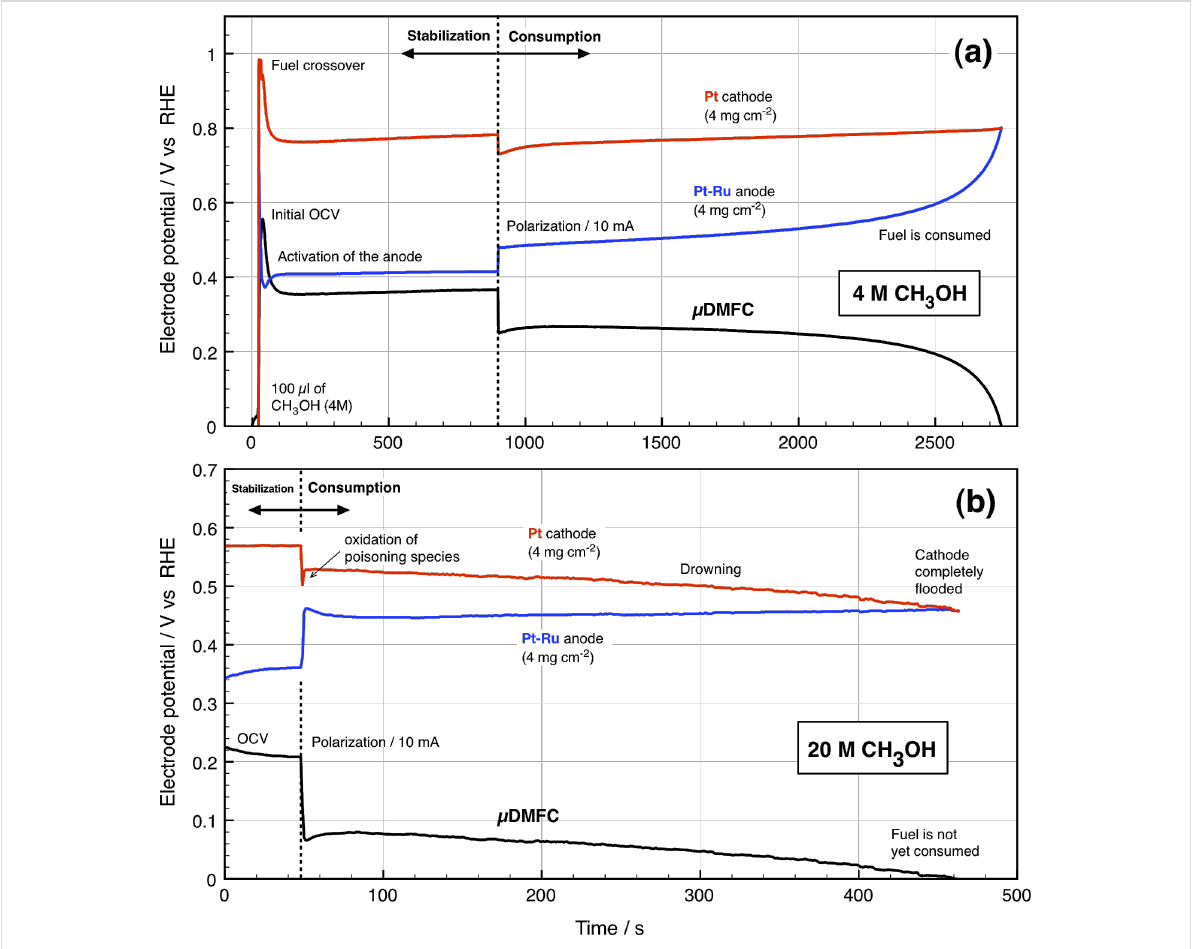
Figure 3: Cell and electrode potential measurements during the consumption of 100 µL of (a) 4 M and (b) 20 M CH 3